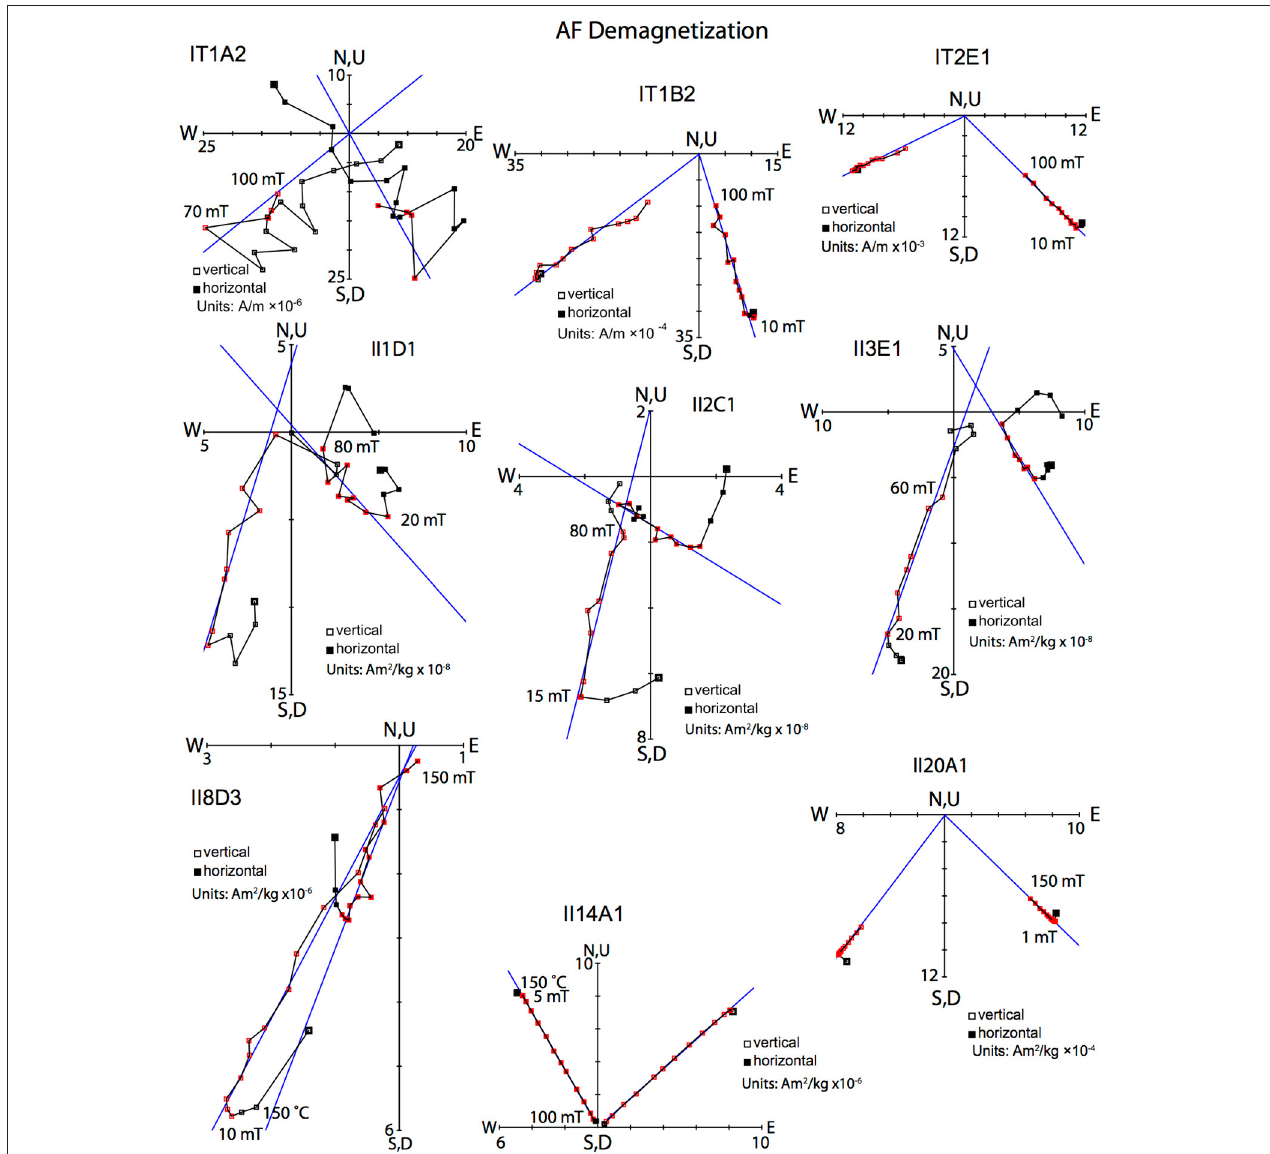
FIGURE 6 | Orthogonal alternating field demagnetization diagrams of representative specimens from the sedimentary rocks of the Itararé Group. Solid (open) symbols represent projections on the horizontal (vertical) plane; red symbols are the demagnetization steps used for principal component analysis (PCA); blue lines are the PCA line-fits. See text for